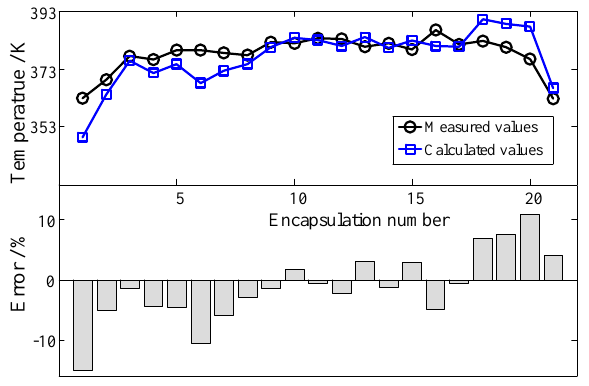
Figure 9. Analysis of simulation and measured values of the temperature.